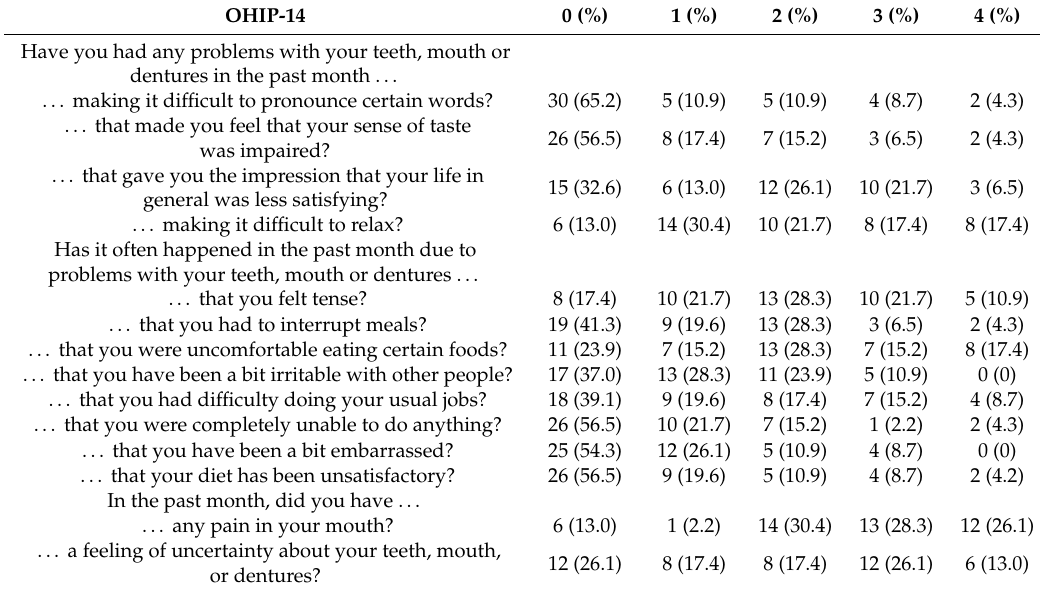
Figure 1. Distribution of the values of 14-item Oral Health Impact Profile (OHIP-14) and PhOX with related boxplots. The median (IQR) of the OHIP-14 score was 17 (23) and the median of the PhOX was 73 (16). Table 4. Distribution of responses of individual OHIP-14 items.